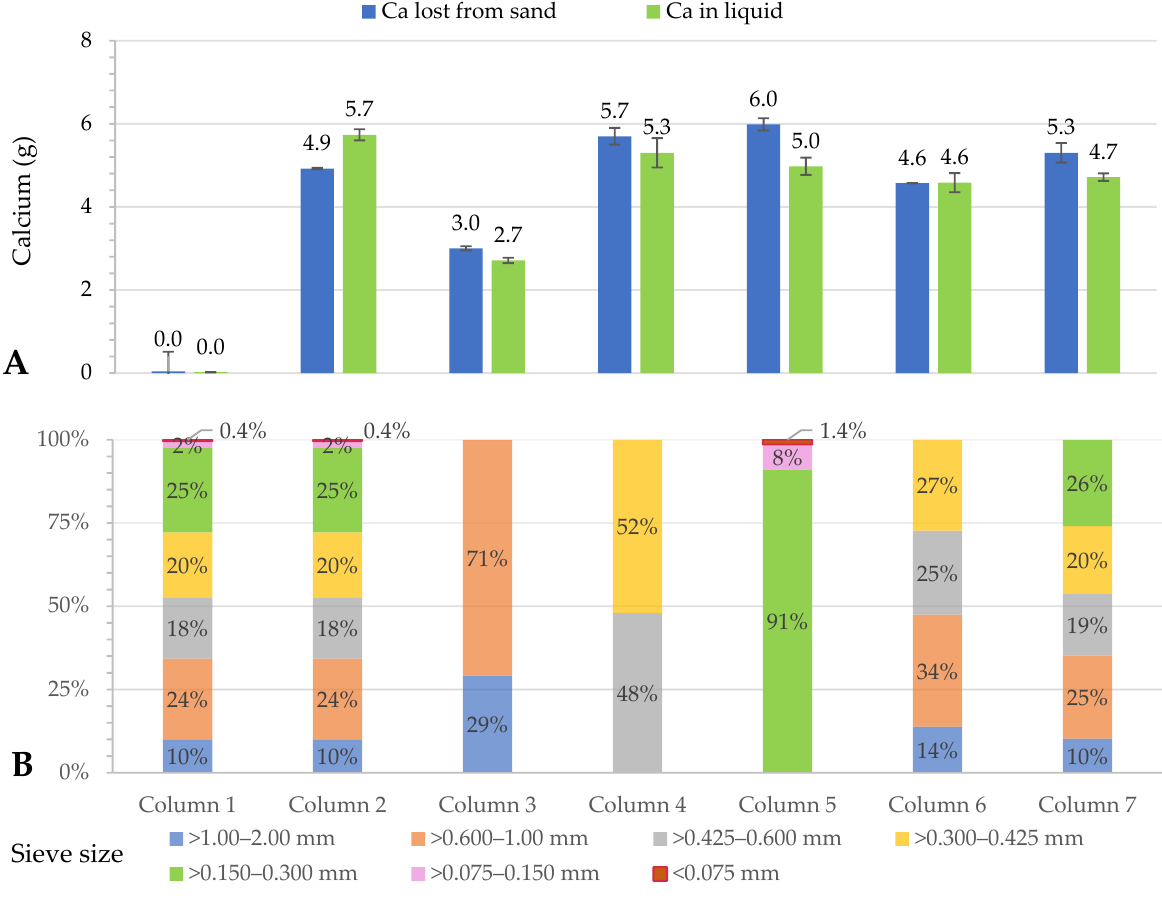
Figure 3. Mass balance of the calcium captured in the effluent and the calcium lost from the sand ( A ), and the distribution of grain size fractions in the columns ( B ). The bars from plot A are aligned vertically with those from plot B, both representing columns 1 to 7.